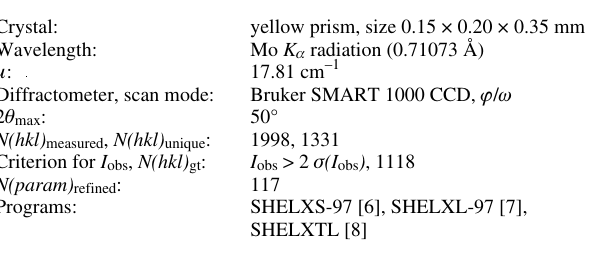
Table 1. Data collection and